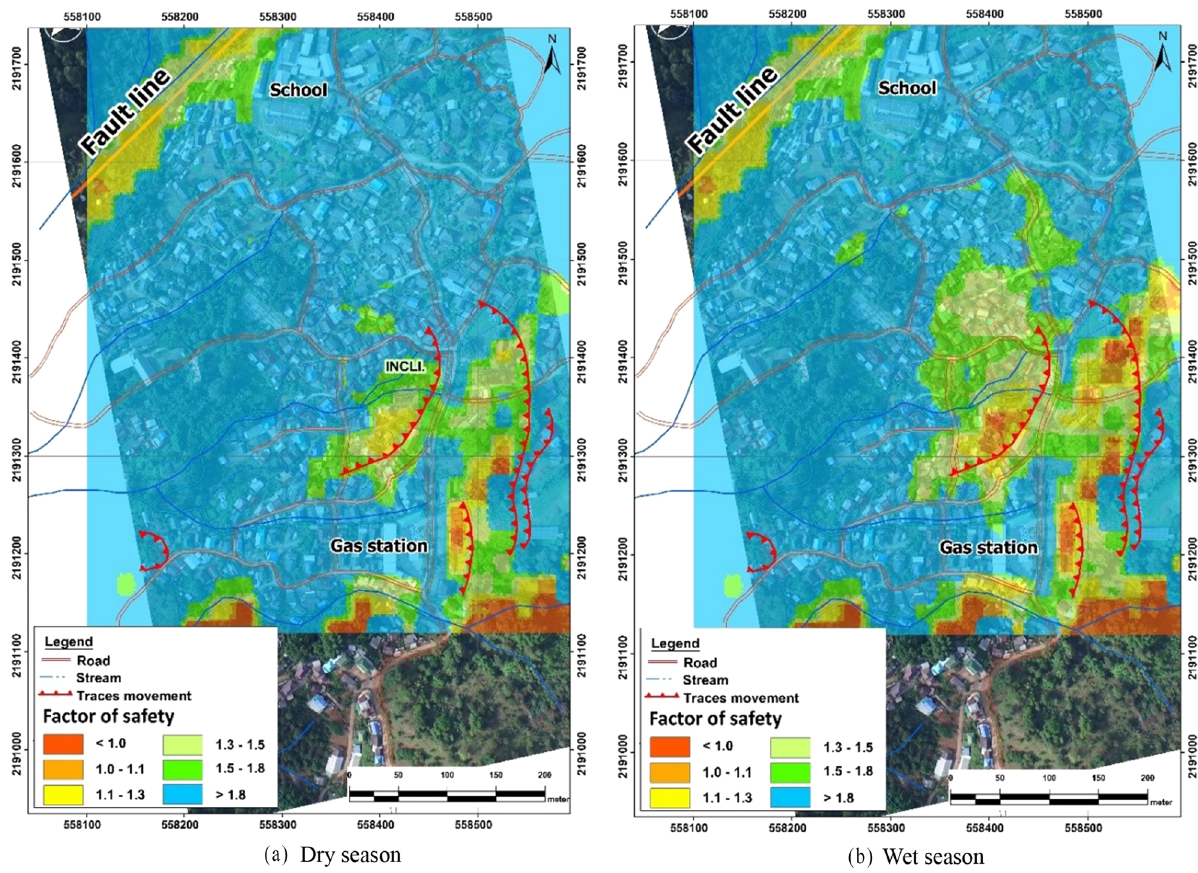
Figure. 9. Factor of safety for dry and wet